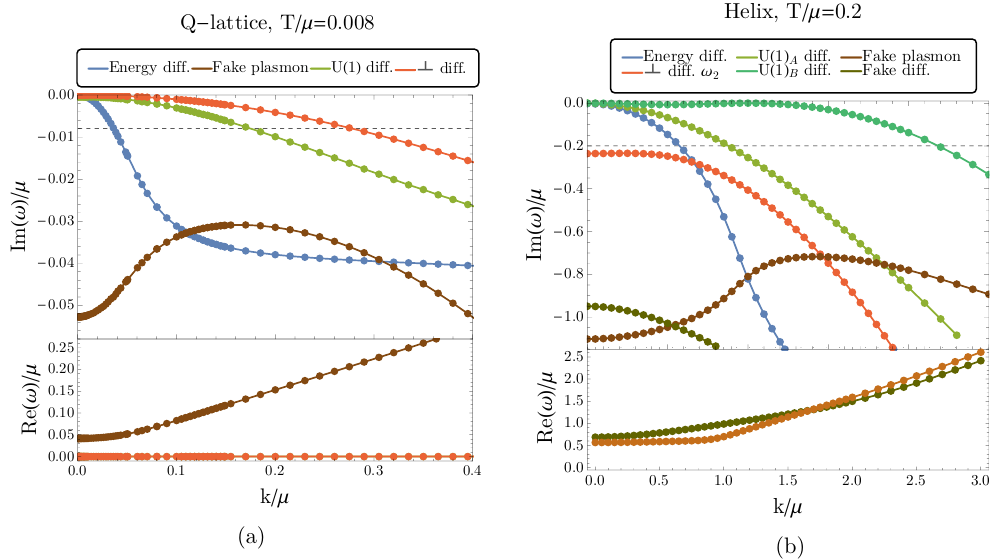
Figure 4. Quasinormal modes at low temperature. This regime corresponds to the lowest tempera- tures shown on (cid:12)gure 3, well below the collision temperature between the hydrodynamic longitudinal momentum mode and a non-hydrodynamic mode to produce the fake plasmon. This new mode (brown) is always present at low temperature in both models and has (cid:12)nite real part already in the long wavelength limit. Importantly, it has the imaginary part of the same order and we observe that even upon increasing the wave vector it never approaches the real axis close enough to produce a sharp peak in the spectrum. In order to compare with the temperature scale, we show it as dashed lines. In the helix, there is another massive \fake di(cid:11)usion" mode (olive line on right panel). In order to distinguish between the energy and U(1) A;B di(cid:11)usion we rely on the high T results and